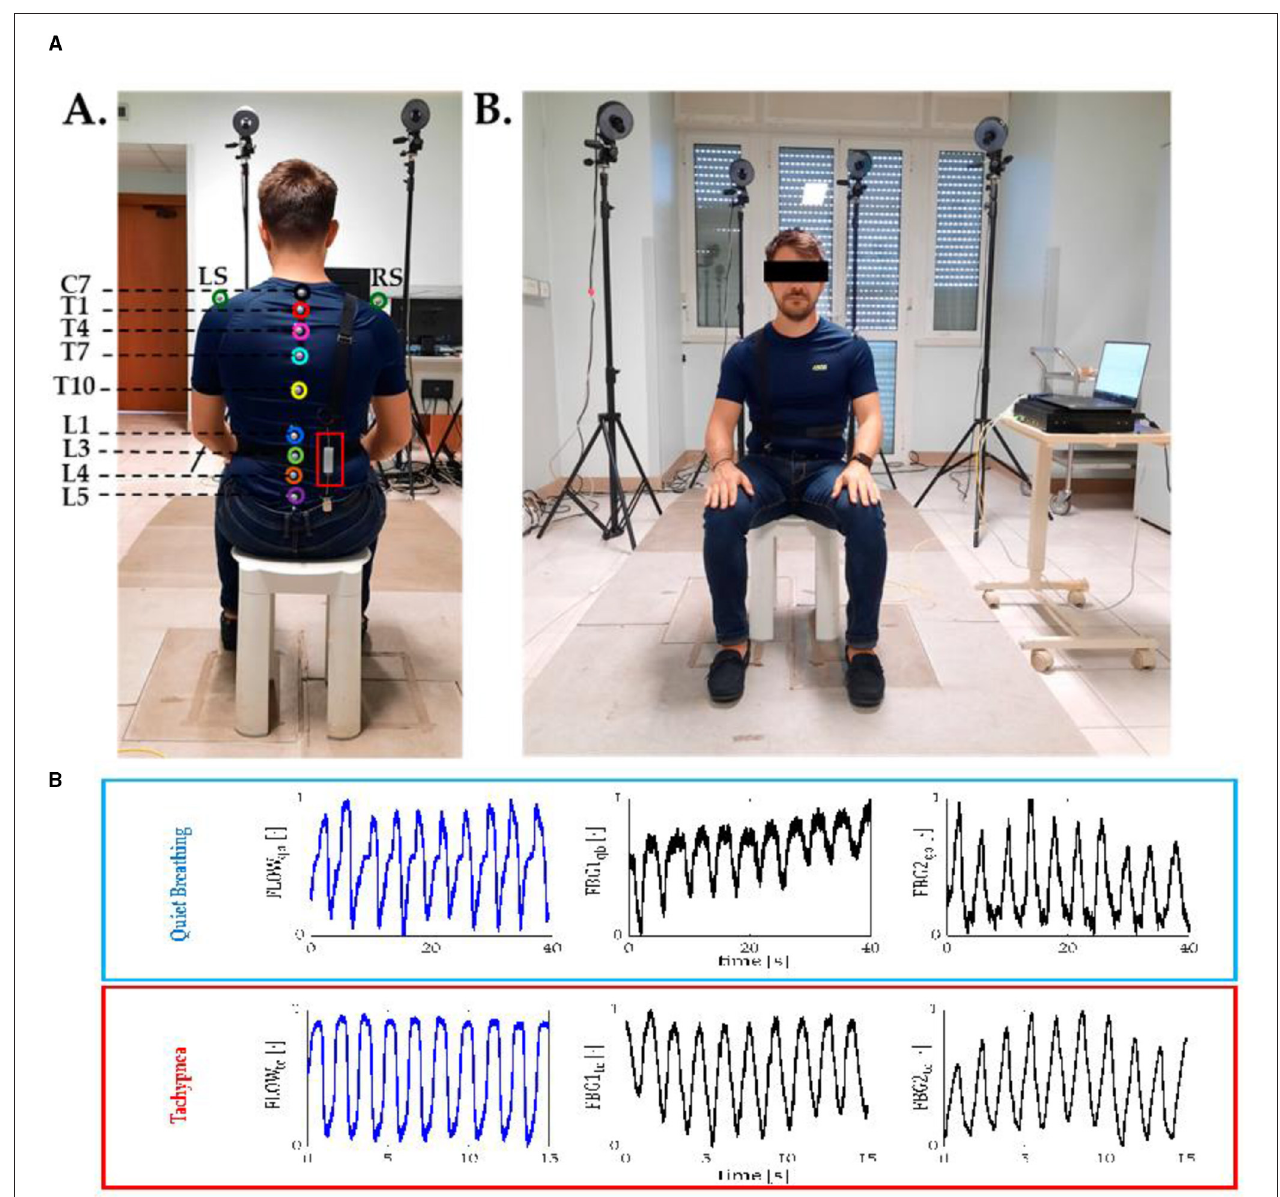
FIGURE 11 | (A) Back view showing the posterior part of the wearable devices with embedded sensor and and front view showing the anterior part of the embedded sensor (118). (B) Signal collected by flow meter and FBG during quite breathing and tachypnea